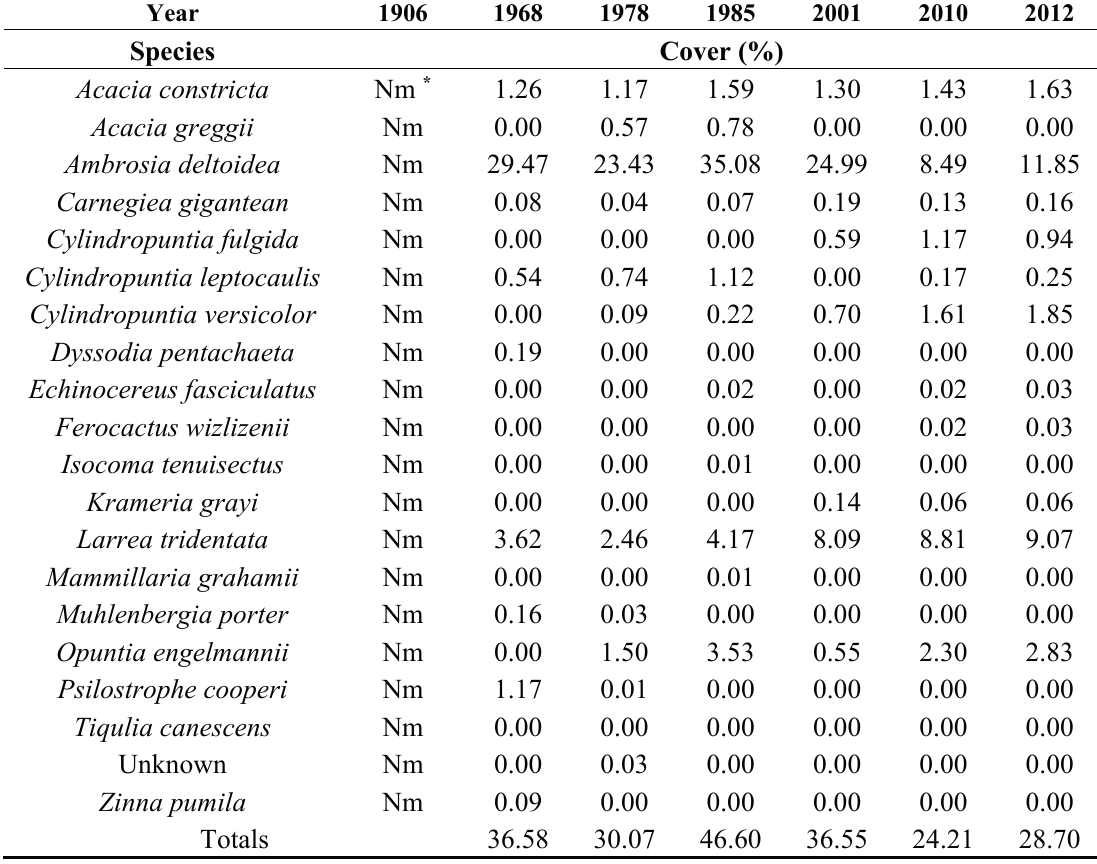
Table 1. History of measurements of cover of perennial vegetation on plot 4 at the Desert Laboratory in Tucson,